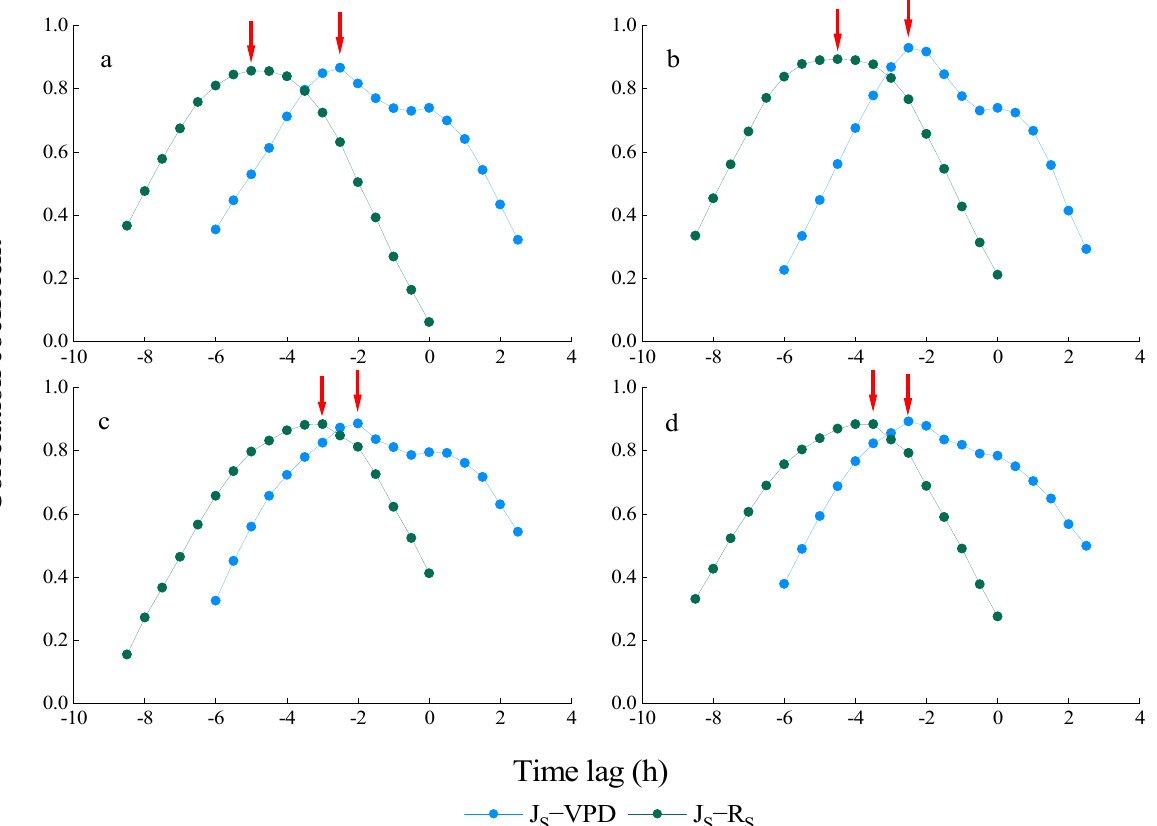
Figure 4. Cross-correlation (r) between mean sap flow (J S ), solar radiation (R S ), and vapor pressure deficit (VPD). The maximum for each curve is retained as the time lag for the time series pair. ( a ) DR treatment; ( b ) HR treatment; ( c ) AR treatment; ( d ) DR treatment. The red arrow is max correlation coeffcient.